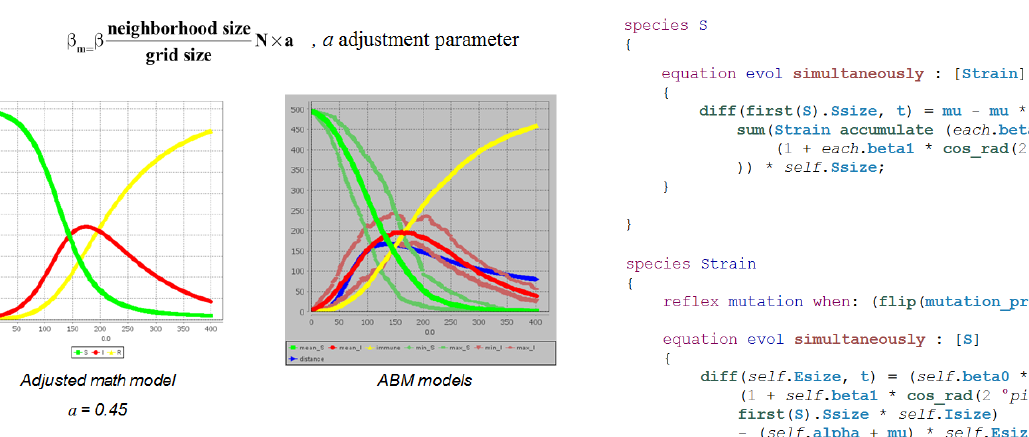
Figure 6. Adjust the beta parameter of SIR model to calibrate EBM with ABM result.